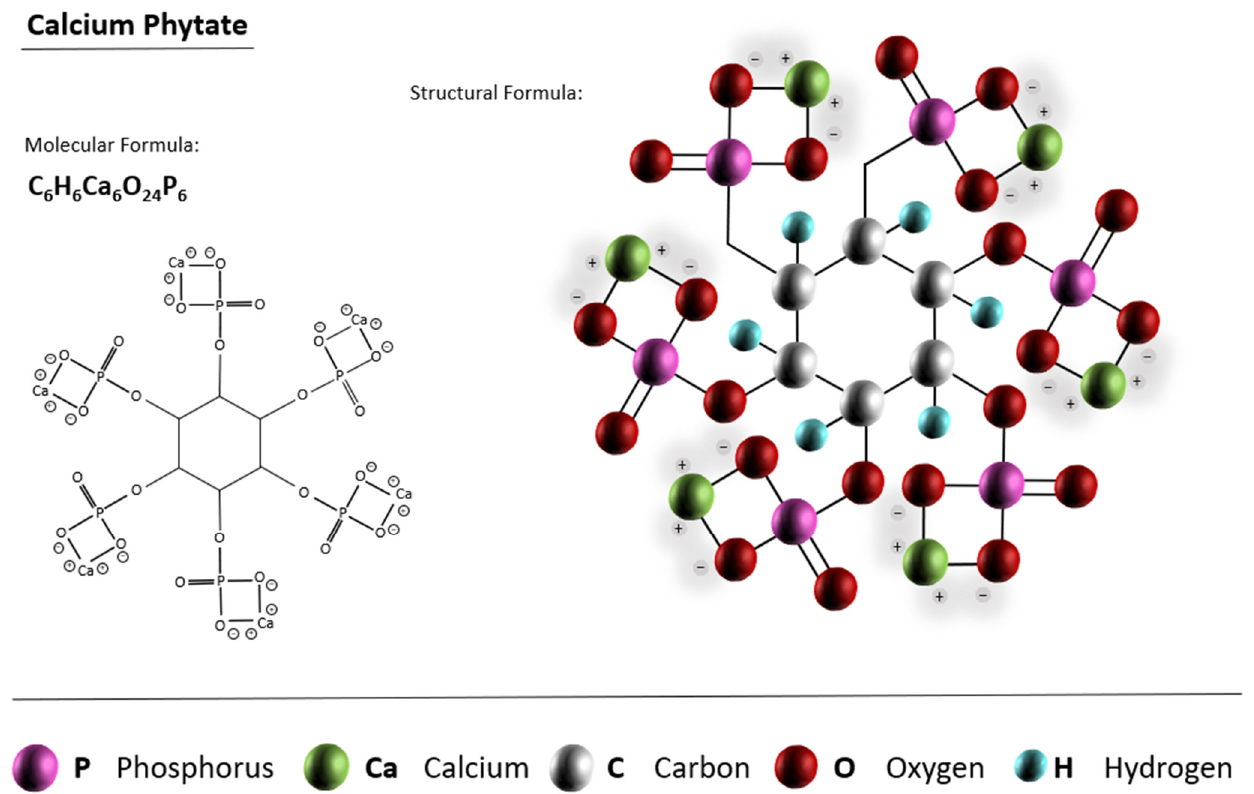
Figure 9. The representation of the calcium phytate structure.